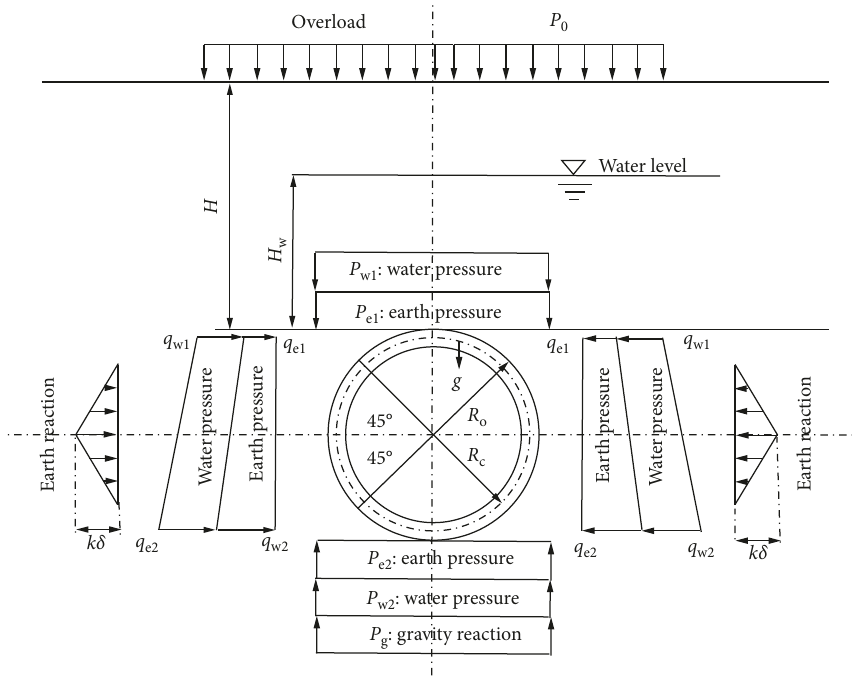
Figure 2: Loads in a conventional model (JSCE